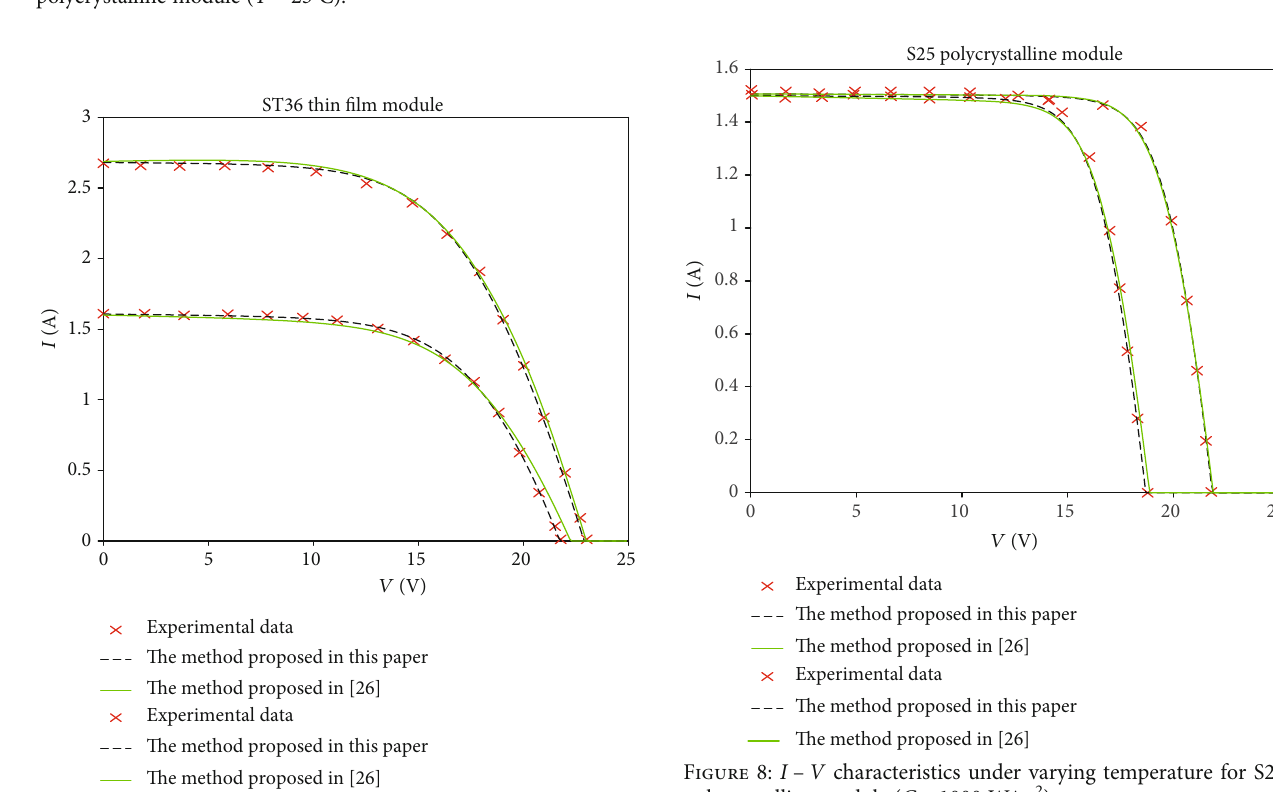
Figure 5: I – V characteristics under varying irradiance for S25 polycrystalline module ( T = 25 ° C).